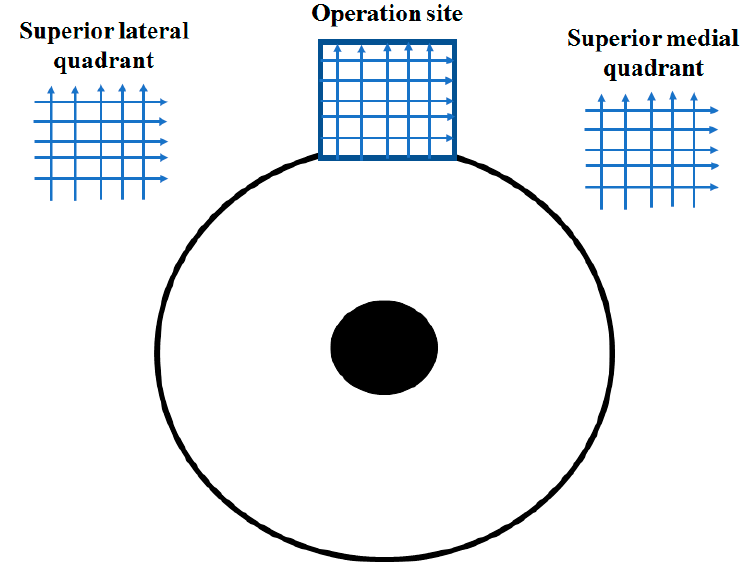
Figure 2. Schematic presentation of OCT evaluation of the surgery site and adjacent areas in the superior hemisphere of the eye globe. At each site, five horizontal and five vertical Raster scans were obtained.